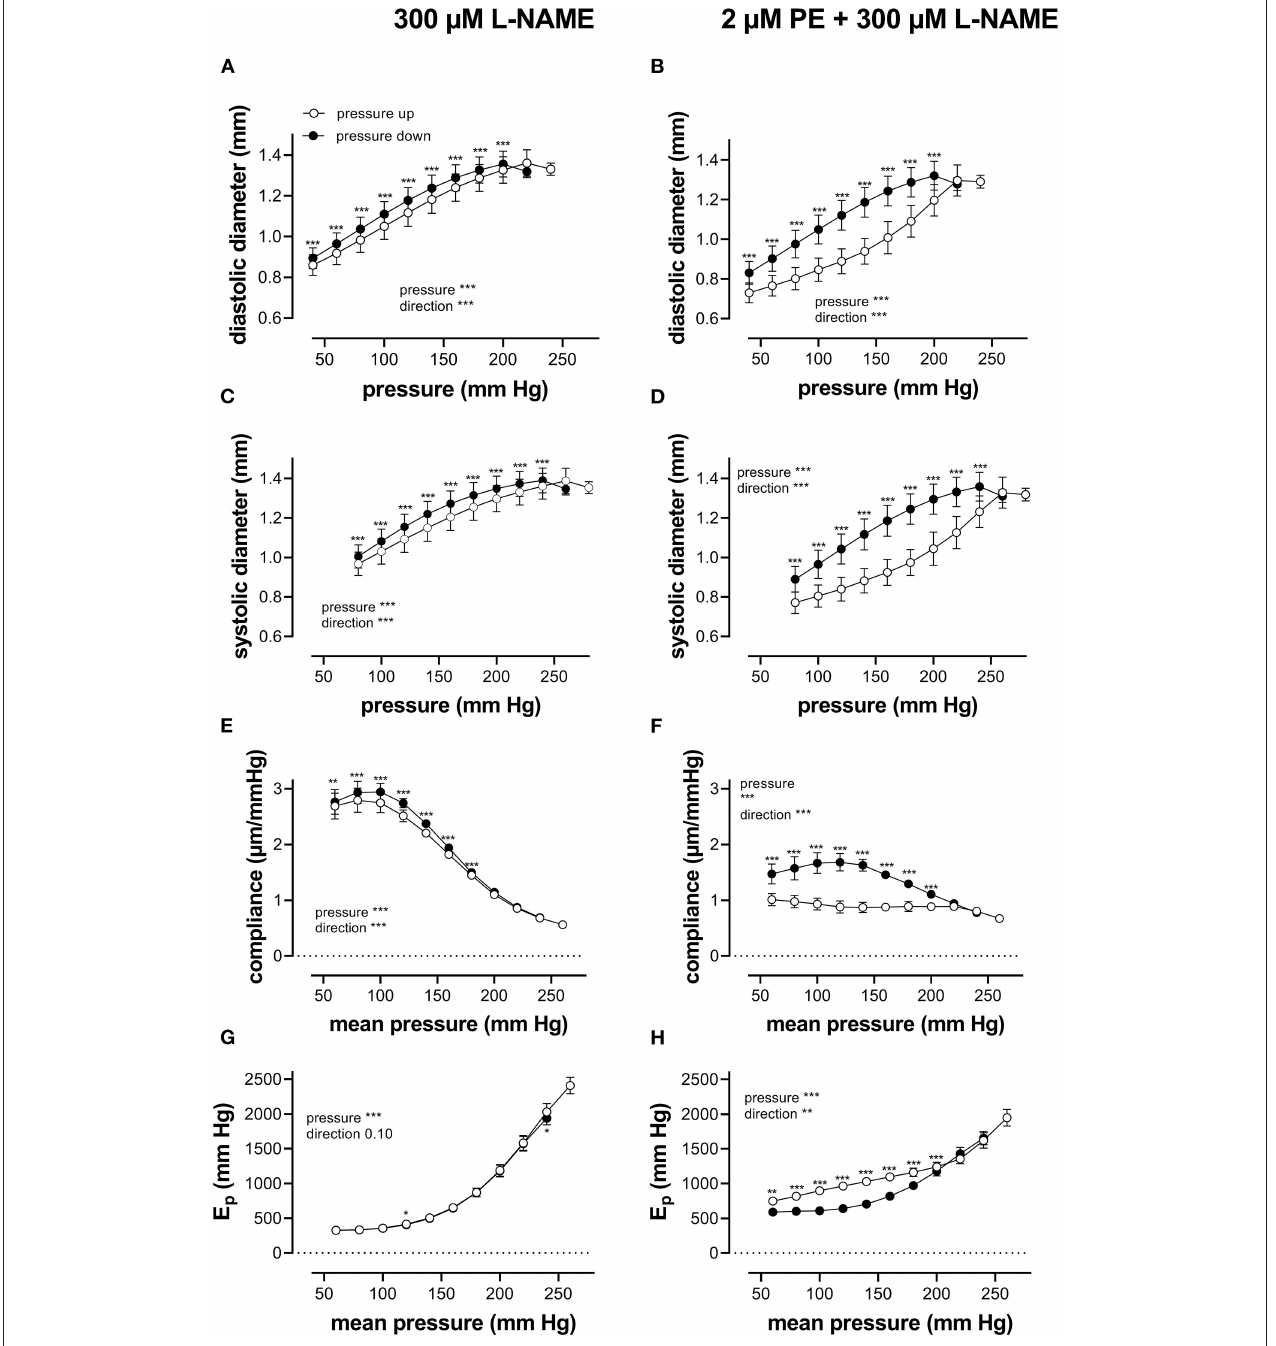
FIGURE 3 | Aortic segments displayed considerable pressure- and contraction-dependent hysteresis. Aortic segments were treated with 300- µ M L-NAME in the absence (A,C,E,G) and presence (B,D,F,H) of 2 µ M PE and subjected to cyclic stretch with an amplitude of 40mm Hg, ranging from 40–80mm Hg to 240–280mm Hg (upward direction, open symbols, up) and back to 40–80mm Hg (downward direction, closed symbols, down). Diastolic and systolic diameters (A–D) , compliance (E,F) , and Peterson’s elastic modulus (E p , G,H ) were determined in aortic segments of 7 C57Bl6 mice (data points ± SEM). Data points for the upward pressure steps (open symbols, up) were compared at any given pressure with data points for the downward pressure steps (closed symbols, down) with two-way RM ANOVA with Sidak’s multiple comparison test. * p < 0.05, ** p < 0.01, and *** p < 0.001.